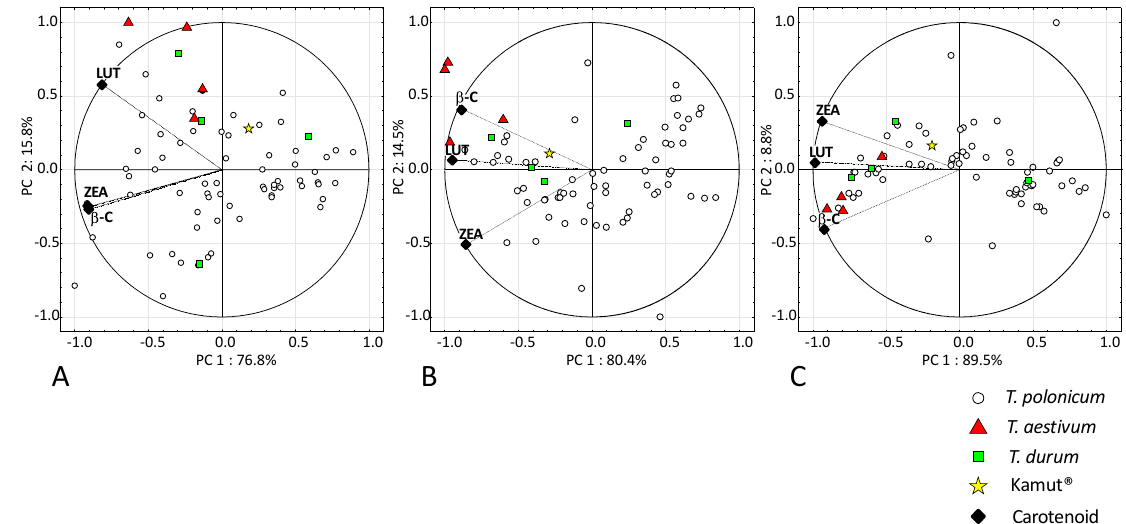
Figure 3. Biplots presenting the results of the principal component analysis for the concentrations of three carotenoids in the flour ( A ), bran ( B ), and grain of the analyzed wheat accessions and cultivars ( C ). LUT—lutein. ZEA—zeaxanthin, β‐ C— β‐ carotene.